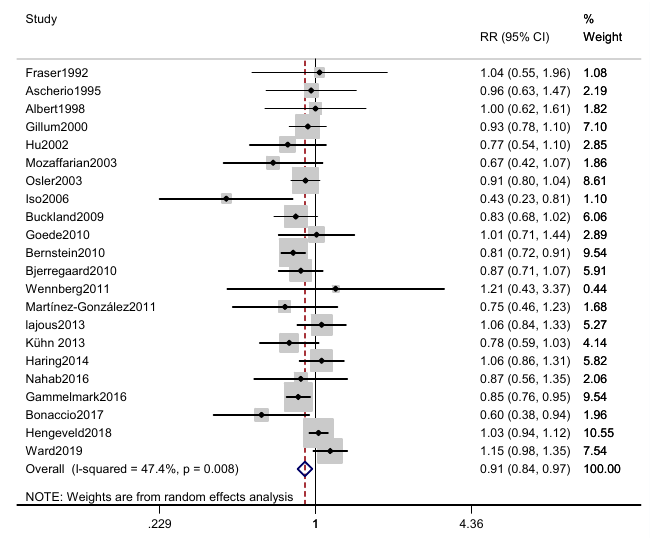
Figure 2. Forest plot of fish consumption with CHD incidence. The pooled effect was calculated by using a random-effects model. The diamond denotes summary risk estimate, and horizontal lines represent 95% CI. Abbreviations: RR, relative risk; CI, Confidence interval.